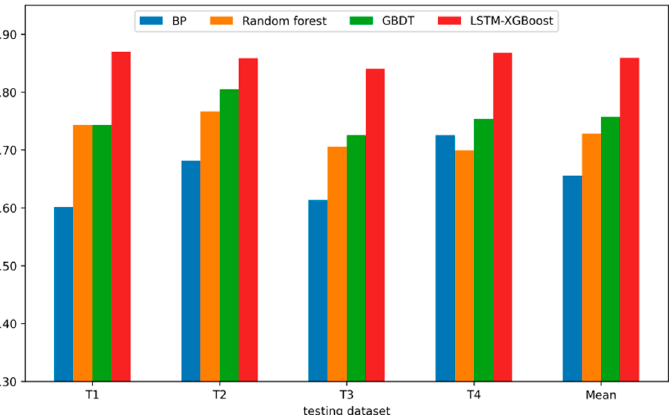
Figure 12. Accuracy P of heavy overload prediction models of public transformer based on various algorithms.